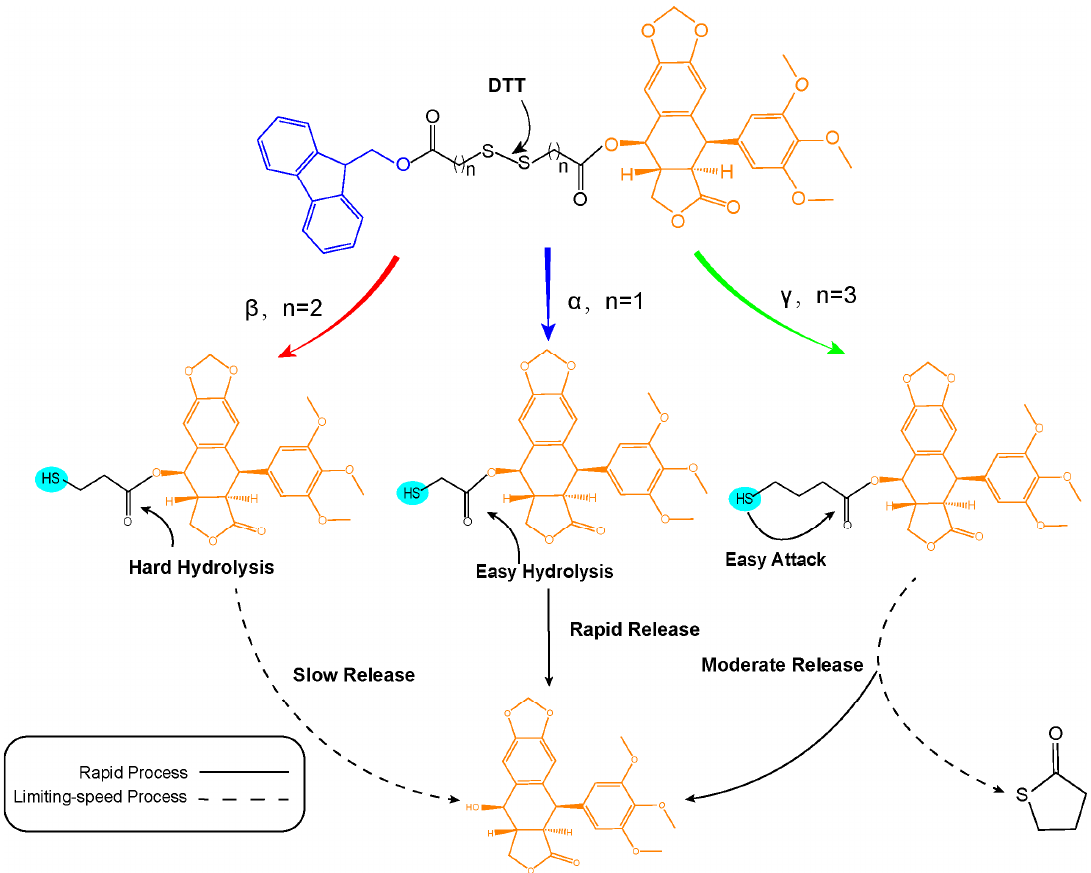
Figure 3. Mechanisms of the reduction-responsive release of prodrugs.